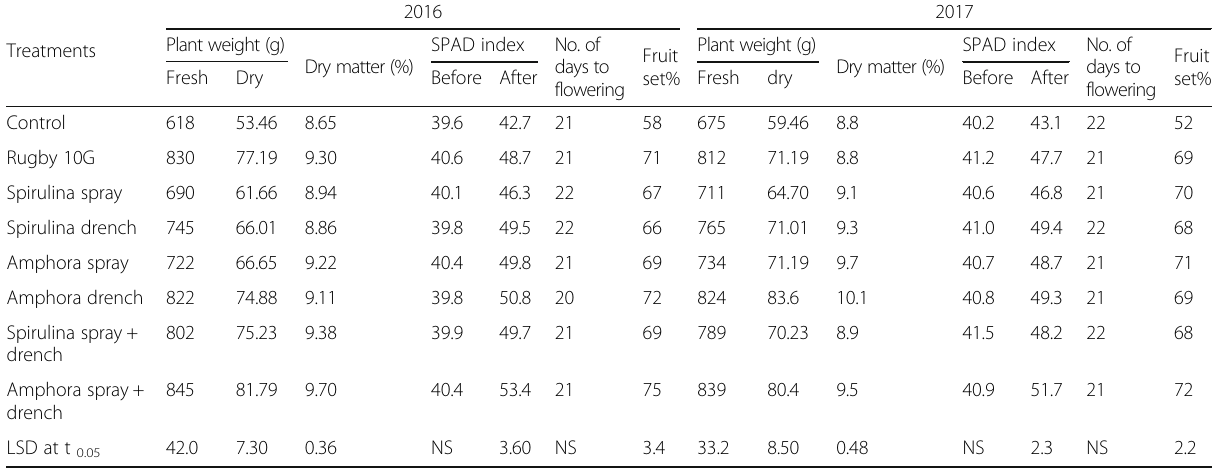
Table 2 Effect of algal treatments of cucumber Hesham hybrid compared with control and Rugby nematicide on plant fresh and dry weight, dry matter percentage, chlorophyll SPAD index, number of days to flowering, and fruit set percentage under infested soil with root-knot nematodes in 2016 and 2017 seasons